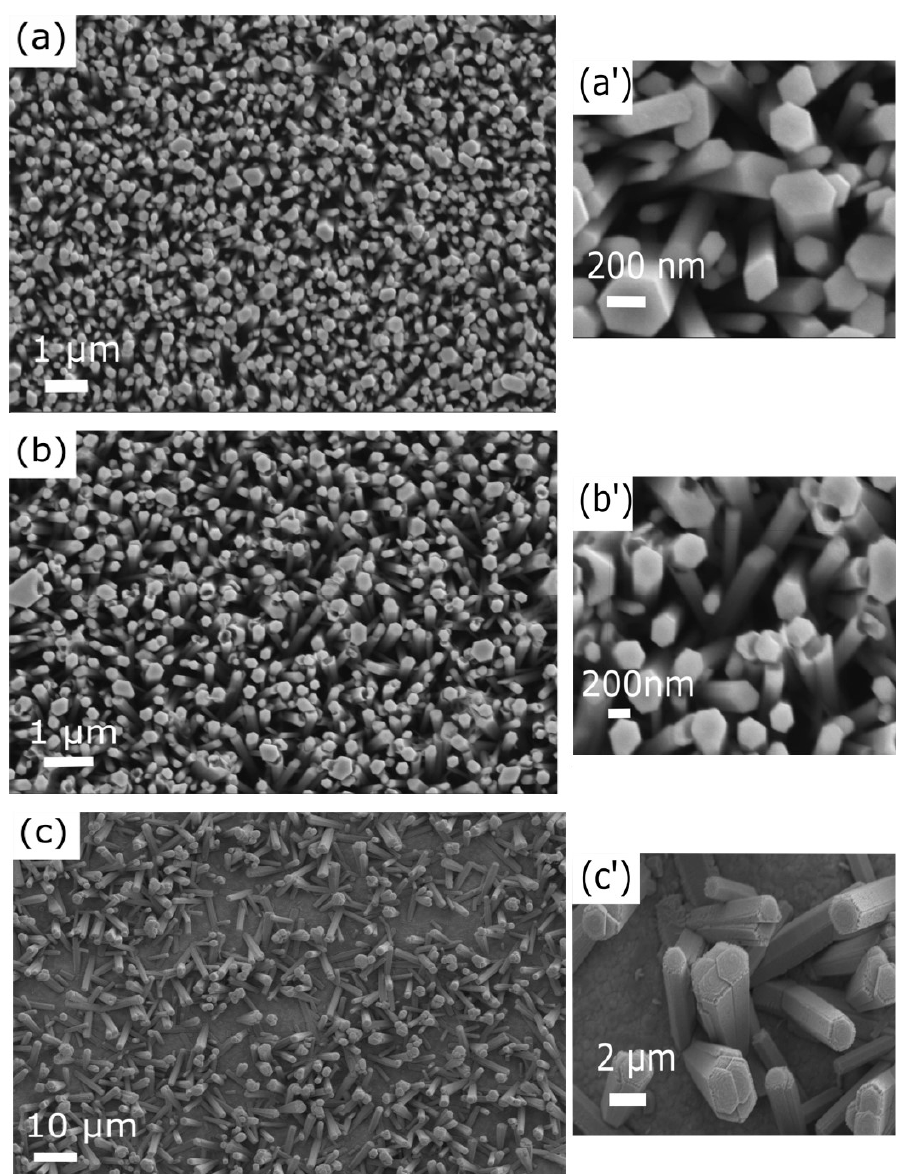
Figure 4. SEM images of the ZnO NWs grown on a ( a ) ZnO (ALD)/ITO/Si substrate; ( a’ ) magnified image; ( b ) as-printed (non-sintered) ZnO seed layer/ITO/PET; ( b’ ) magnified image; ( c ) sintered printed ZnO seed layer/ITO/PET; ( c’ ) magnified image.